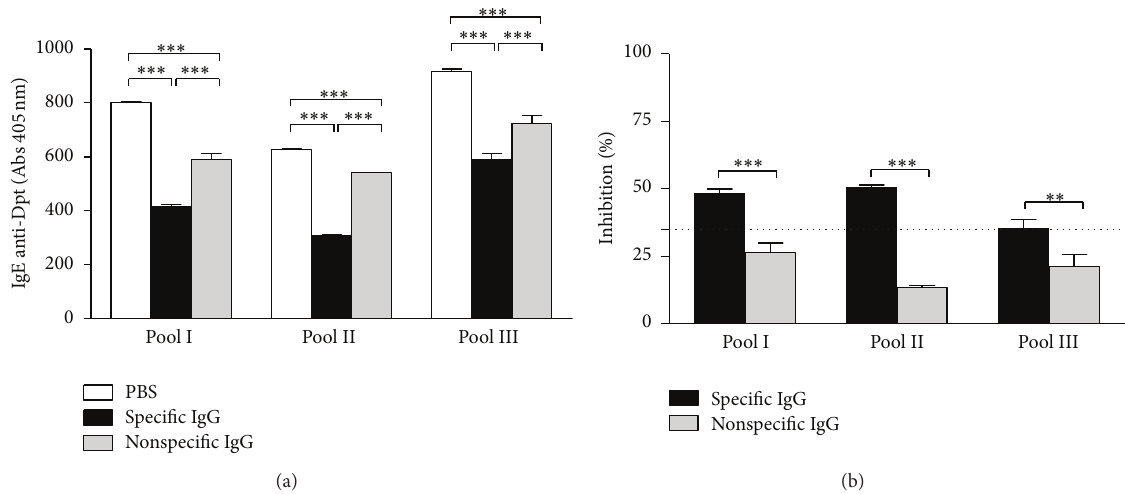
Figure 5: Inhibition ELISA results showing the blocking capacity of specific and nonspecific purified IgG antibodies for IgE reactivity to Dermatophagoides pteronyssinus (Dpt) allergen extract in serum pools of atopic patients. Three serum pools (I, II, and III) with different positivity for antibody classes were used as follows: pool I (IgE+, IgG1+, and IgG4 − ); pool II (IgE+, IgG1 − , and IgG4+); and pool III (IgE+, IgG1+, and IgG4+). (a) Levels of IgE anti-Dpt expressed in absorbance (405 nm). Statistically significant differences were determined by one- way ANOVA and the Bonferroni posttest ( ∗∗∗ 𝑃 < 0.0001 ). (b) Percentage of inhibition of IgE binding by blocking specific and nonspecific IgG antibodies in three serum pools of atopic patients. The dashed line indicates a threshold inhibition value of 35%. Statistically significant differences were determined by Student’s 𝑡 -test ( ∗∗ 𝑃 < 0.01 ; ∗∗∗ 𝑃 < 0.0001 ).